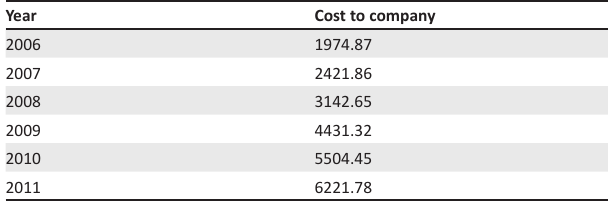
TABLE 5: Cost to company standard deviation